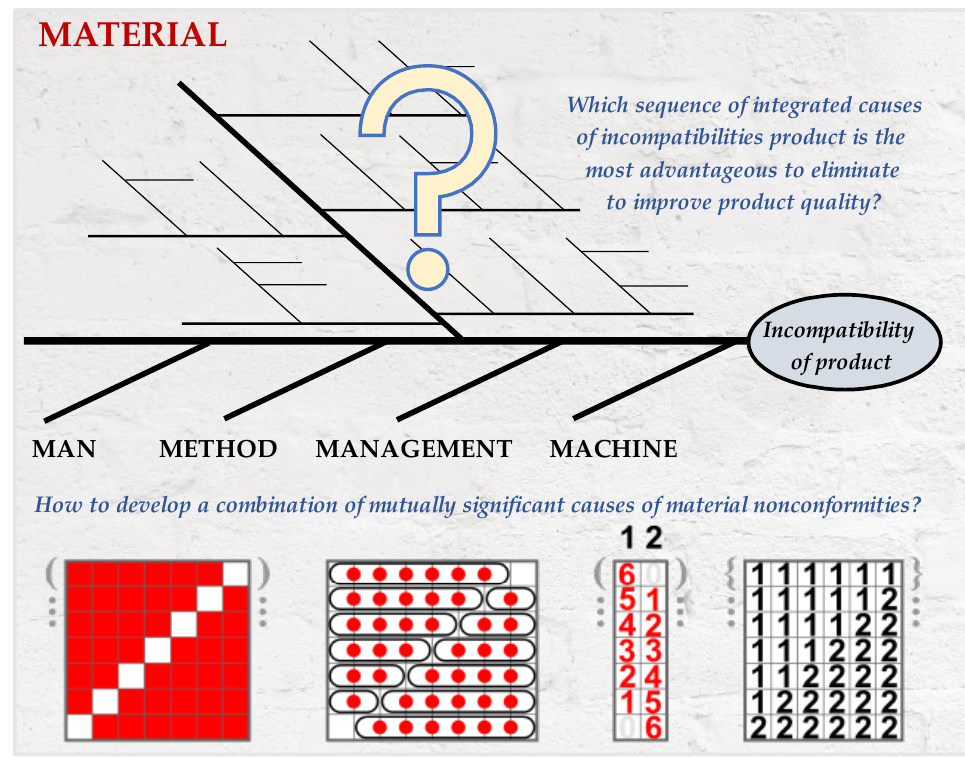
Figure 1. General concept of the method considering a process of the importance of improvement actions in materials of Ishikawa diagram.